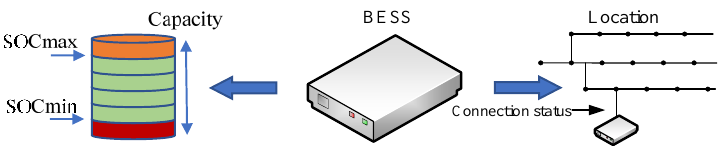
Figure 1. Battery energy storage systems (BESS) coordination control architecture model.